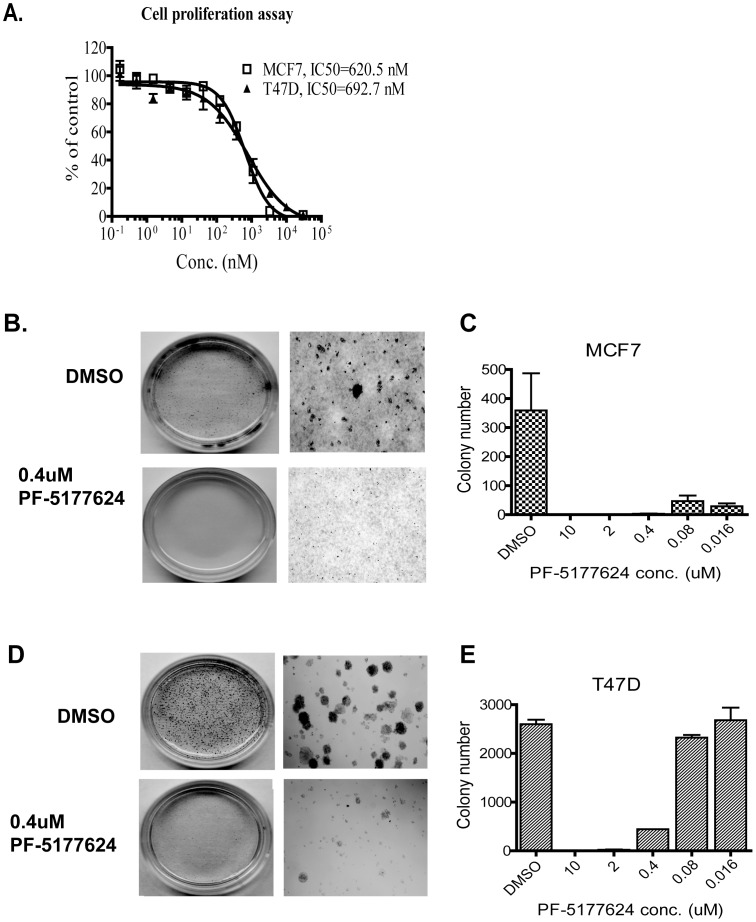
PF-5177624 inhibited cell proliferation and cell transformation in MCF7 and T47D cells.Cells were cultured in complete medium and treated with PF-5177624 for 72 hours prior to addition of rezasurin to determine the IC50 value of cell proliferation inhibition by PF-5177624 (A). Soft agar assays were performed in MCF7 (B and C) and T47D cells (D and E). The images from representative dishes and microscopy are shown to demonstrate colony numbers and morphology (B and D). Colony numbers were also counted (C and E).